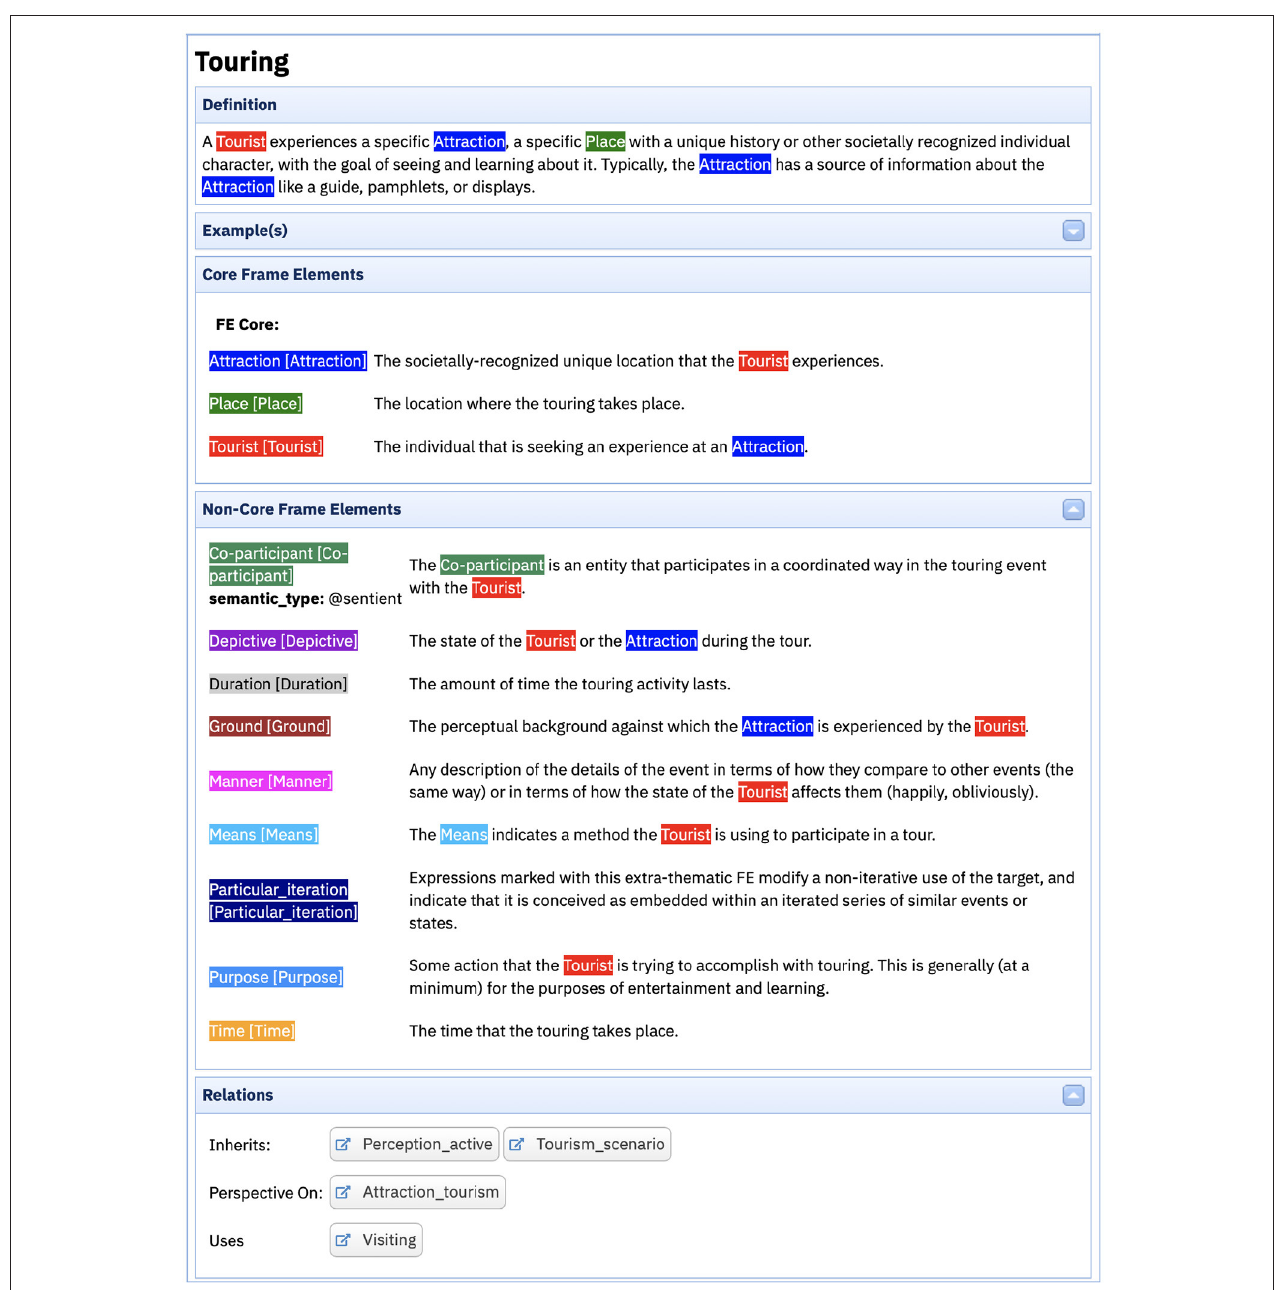
FIGURE 1 | The Touring frame.